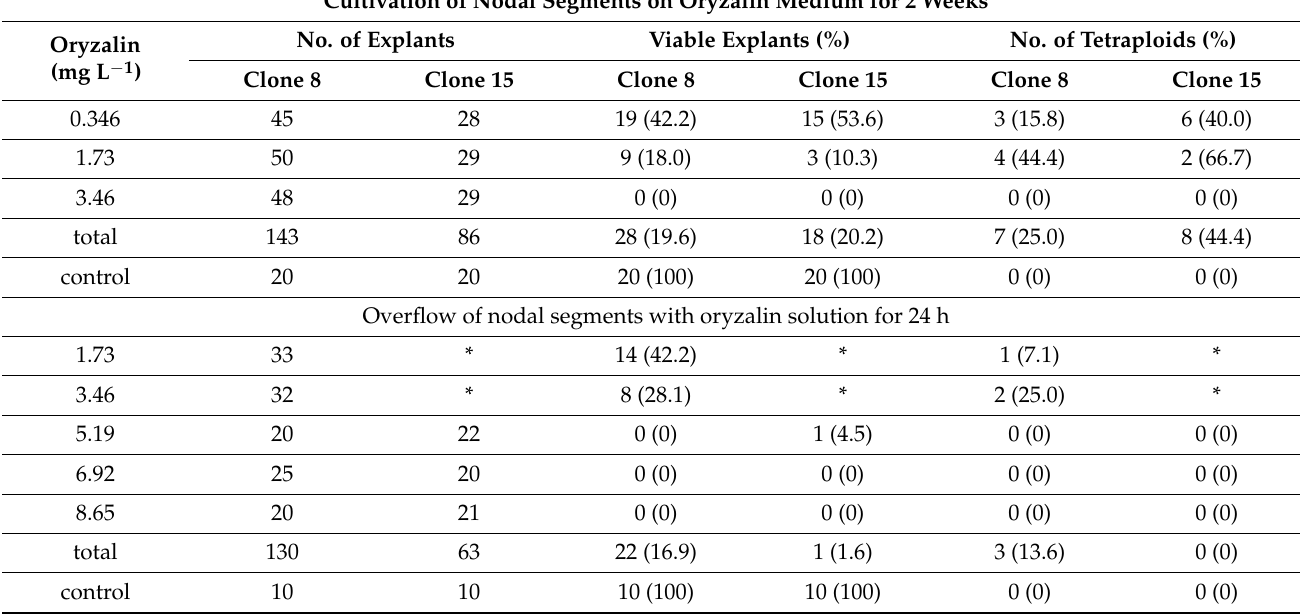
Table 3. Insecticidal activity of essential oil from tetraploid and diploid T. vulgaris.